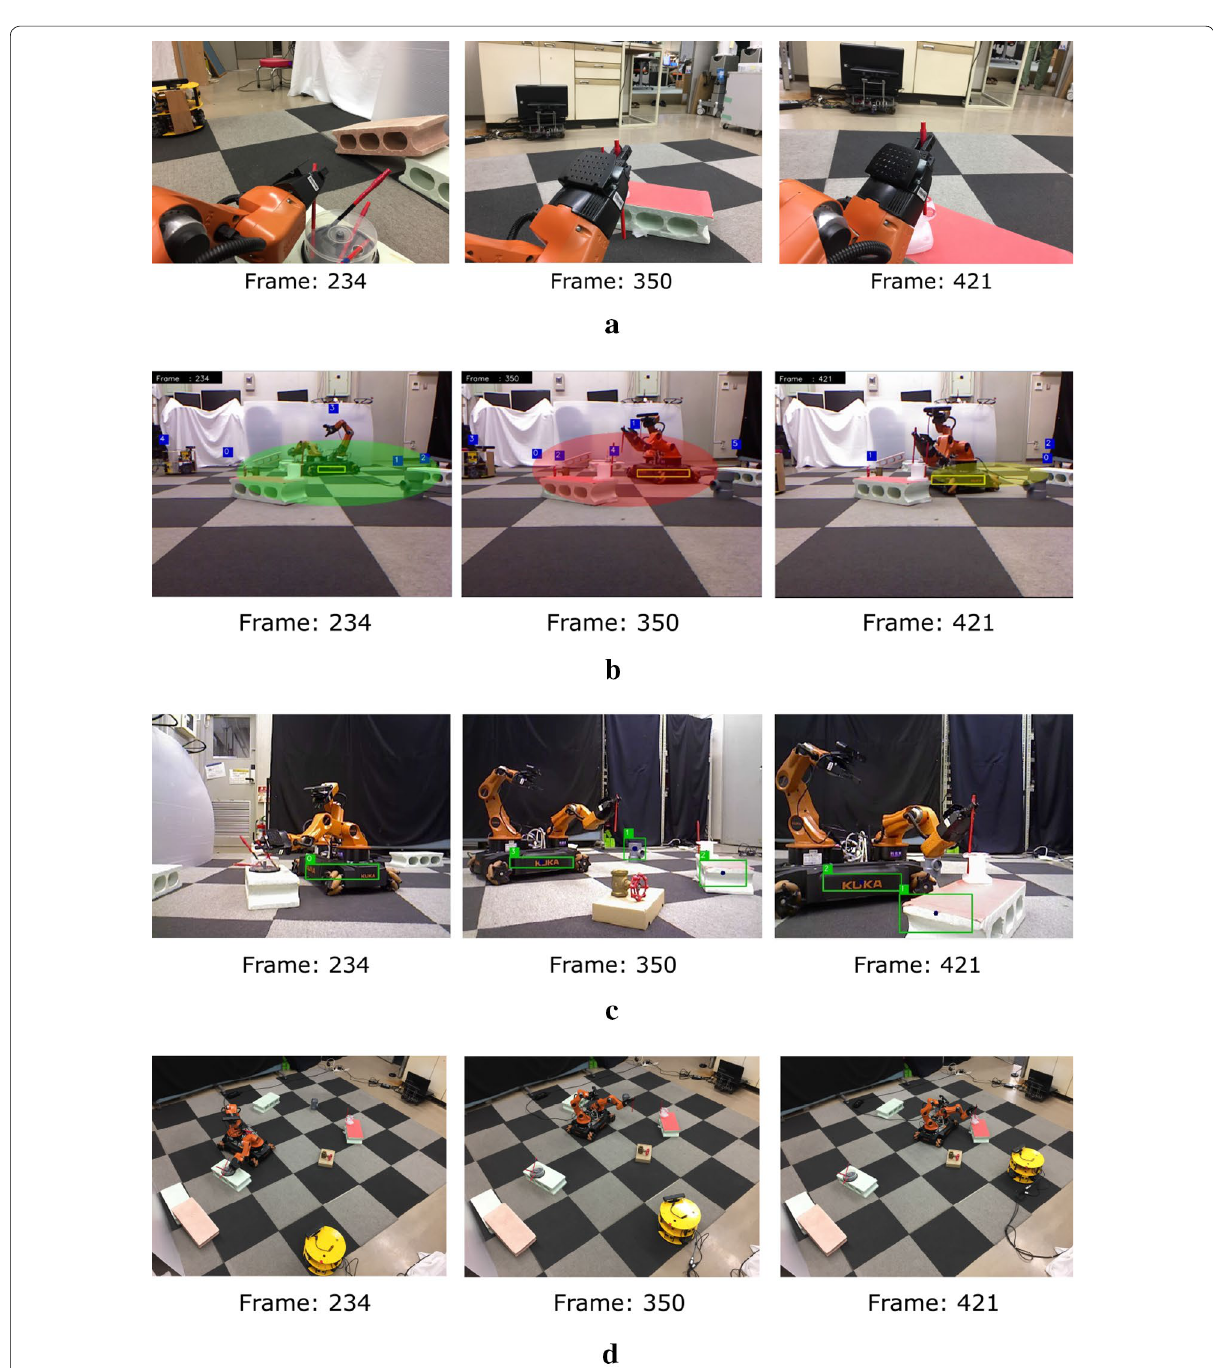
Fig. 14 Images sent by each robot. a View from working robot Robot‑W, b view from Robot‑M W , c view from Robot‑M L , d view from